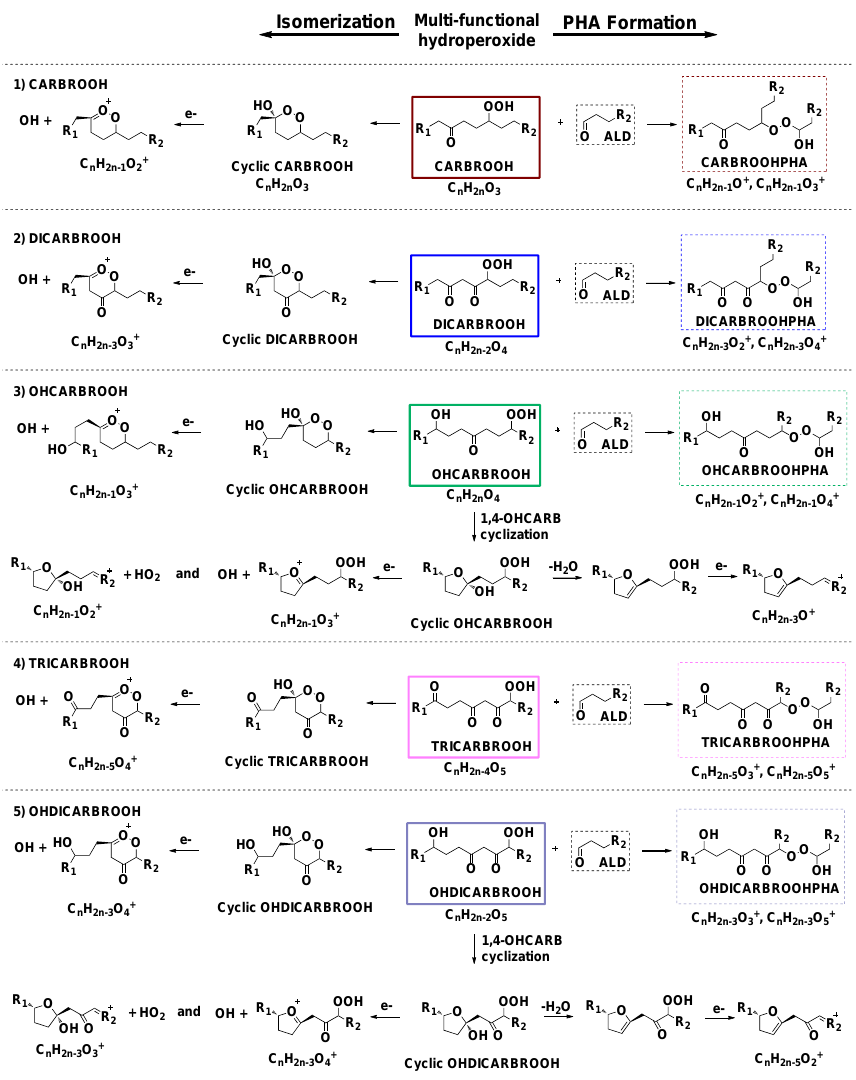
Fig. 2. General mechanism for particle-phase chemistry involving PHA formation (right-hand side) and potential isomerization (left-hand side) from higher functionalized products (solid boxed) formed along channel 2 in Fig. 1. R 1 and R 2 are alkyl groups. One isomer is shown. Dashed boxed compounds indicate PHA structures for which AMS ion tracers exist. General chemical and ion formulae for multifunctional hydroperoxides and proposed PHA and isomerization products are shown, where n=12. Analogous products for hexylcyclohexane and cyclododecane would have an additional degree of